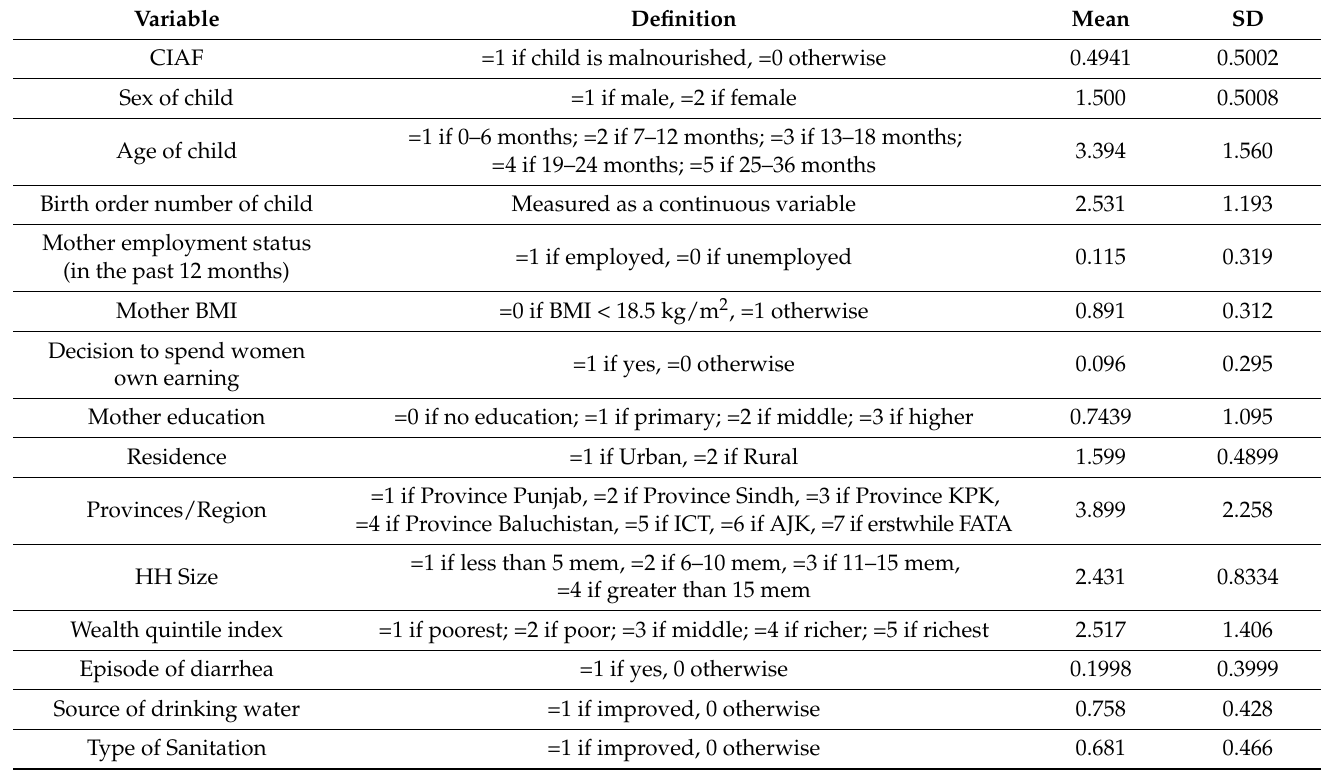
Table 1. The definitions and the descriptions of different